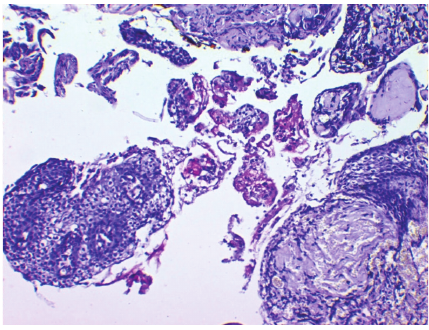
Figure 11: Photomicrograph of the lesion showing mucus cells (mucicarmine positive), clear cells, and intermediate cells (H&E,